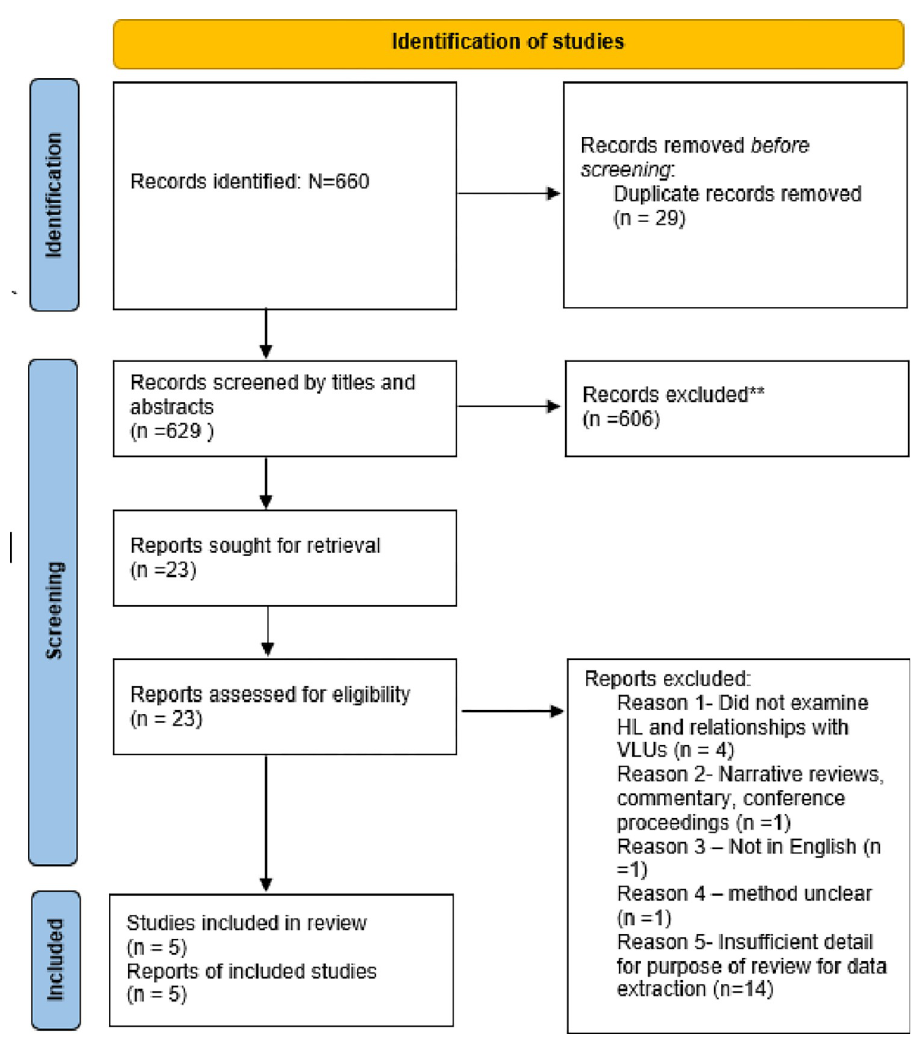
Fig 1. PRISMA flow